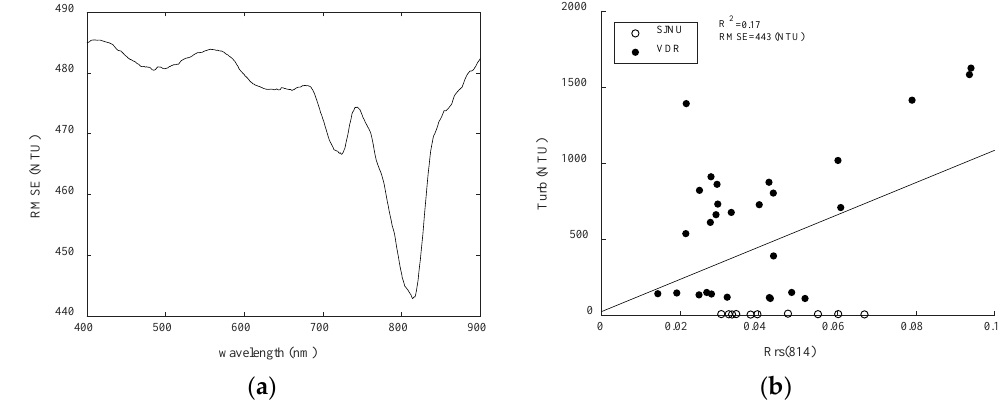
Figure 7. Turbidity results of the one-band model (T1) in SJNU and VDR. ( a ) Root mean square error variation between R rs −1 ( λ 5 ) and measured turbidity when λ 5 is in the 400–900-nm range; ( b ) optimal correlation between R rs (814) and measured turbidity (Turb).